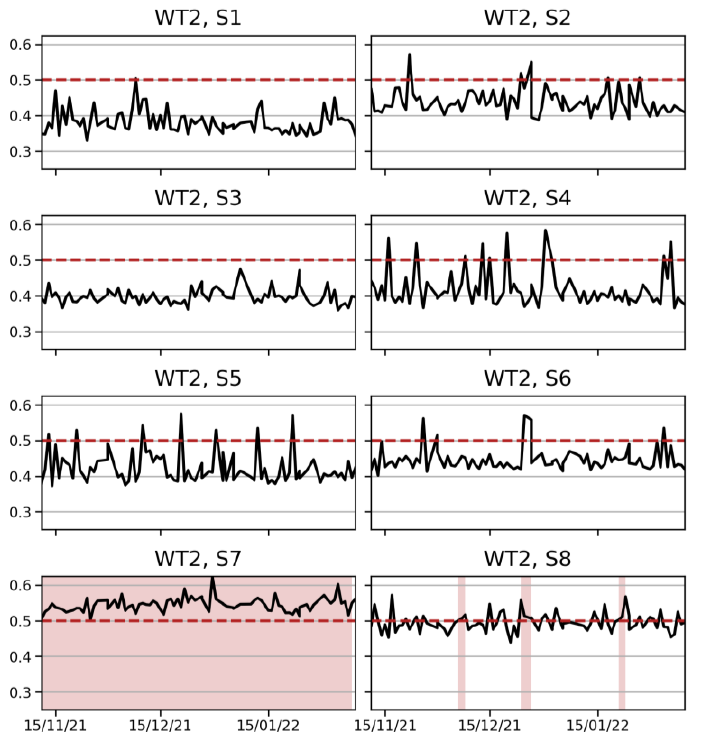
Figure 9. Fault detection based on isolation forest models. Health indices for the drivetrain components monitored with accelerometers S1–S8 of WT2. The red dashed line at 0.5 is used to separate normal vibration responses (health index (cid:46) 0.5) from anomalous ones (health index > 0.5). We set the threshold value of 0.5 in accordance with [34]. Red shaded areas represent periods when the alarm notification criterion is active, following three consecutive crossings of the